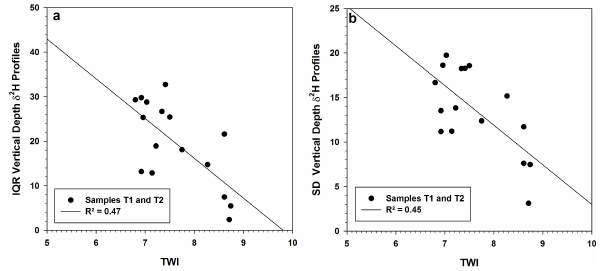
Table 1. Percentage of the vertical depth deuterium profile data along T1 and T2 between +10‰ and − 10‰ difference